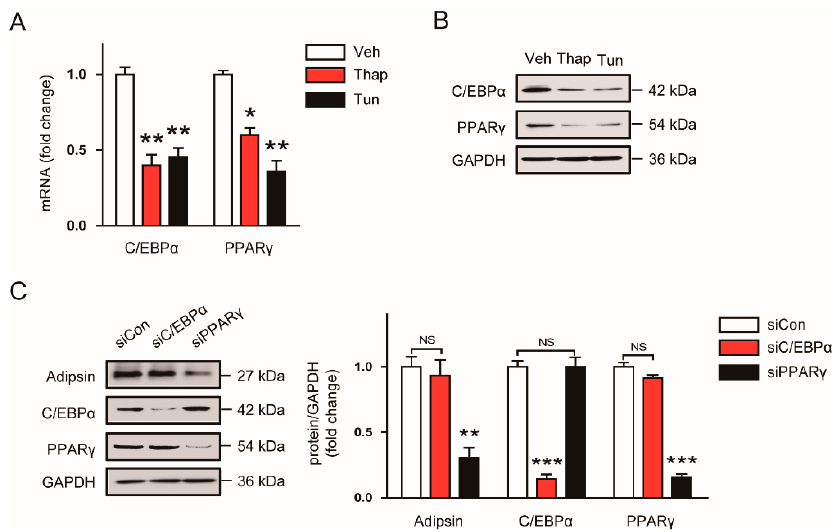
Figure 5. The ER stress-mediated downregulation of adipsin is attributed to reduced expression of peroxisome proliferator-activated receptor γ (PPAR γ ). ( A ) Mature 3T3-L1 adipocytes were treated with vehicle (Veh; DMSO), thapsigargin (Thap 10 nM), or tunicamycin (Tun; 5 μ g/mL) for 24 h. The mRNA levels of CCAAT/enhancer-binding protein α (C/EBP α ) and PPAR γ were analyzed by real-time RT-PCR analysis. ( B ) Western blot analysis of C/EBP α , PPAR γ , and GAPDH in the cells treated with Veh, Thap, or Tun. GAPDH was used as a loading control. (C ) Knockdown of C/EBP α (siC/EBP α ) or PPAR γ (siPPAR γ ) was performed using specific siRNAs for each gene. Scrambled siRNA (real-time) was used as a negative control. The transfected cells were harvested 24 h after transfection, and western blot analysis was performed. The graphs show densitometric quantification of adipsin, C/EBP α , PPAR γ normalized against GAPDH. All data are represented